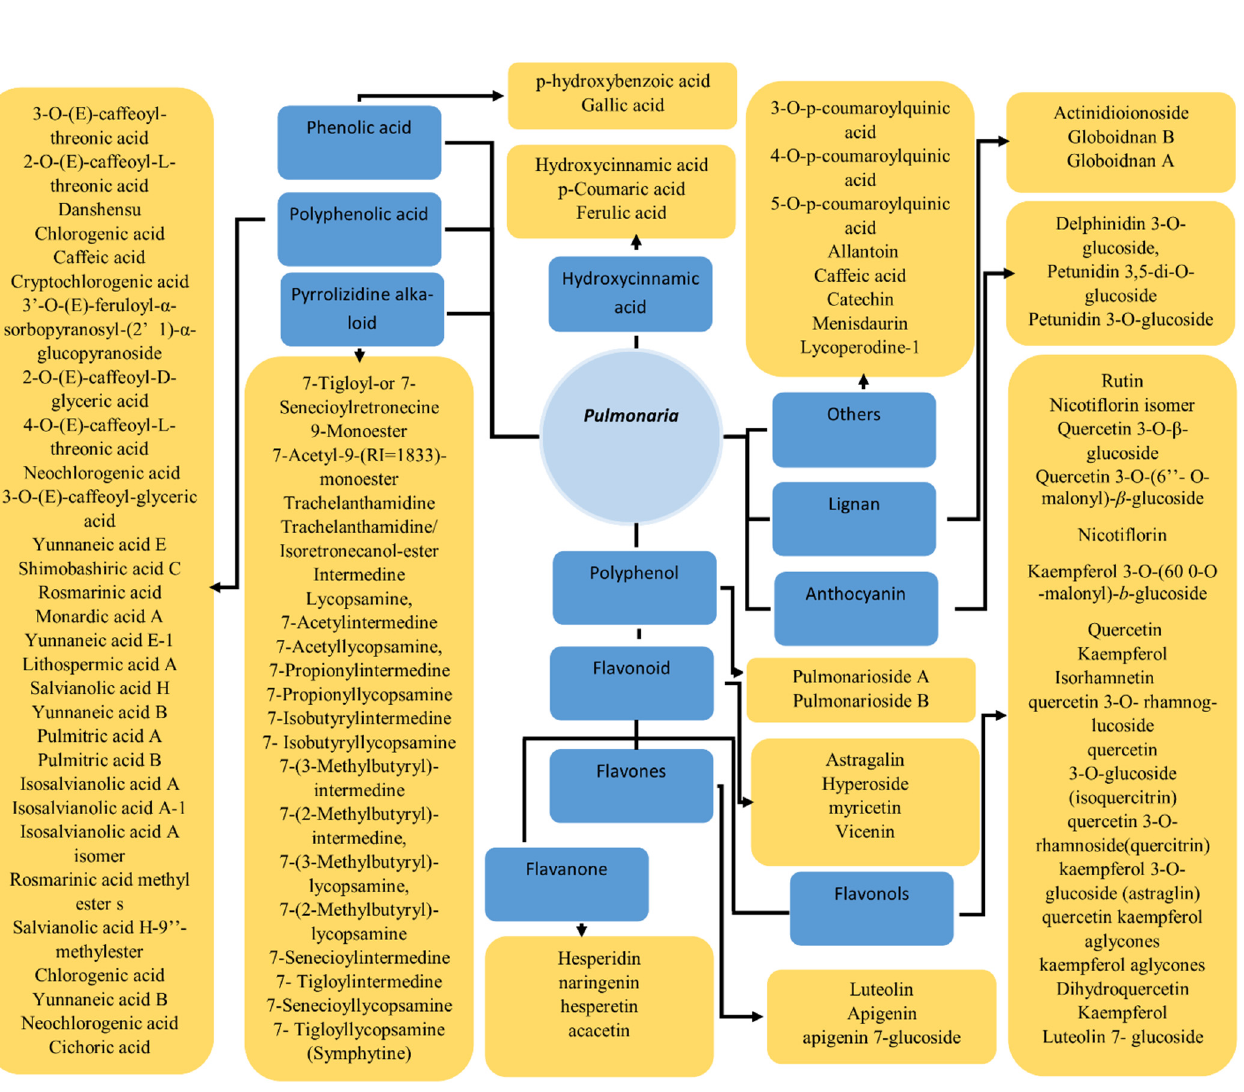
Figure 1. Phytochemicals reported form the lungworts.